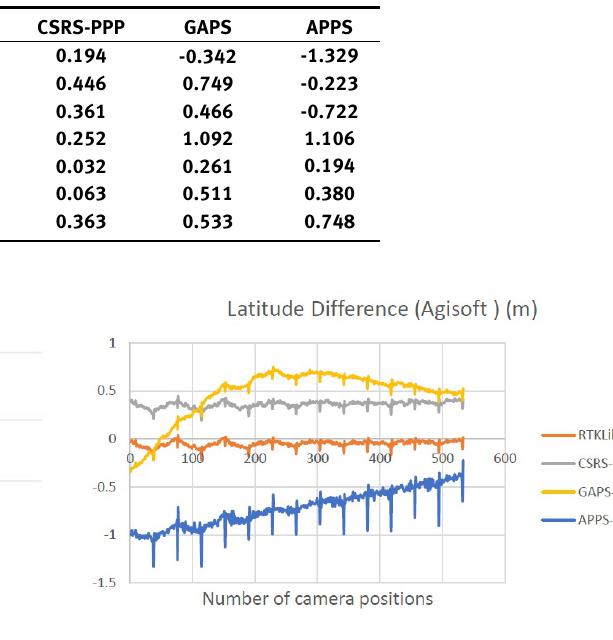
Fig. 8. Latitude differences between camera coordinates that were produced by Agisoft Metashape and the software that was utilized in this project.